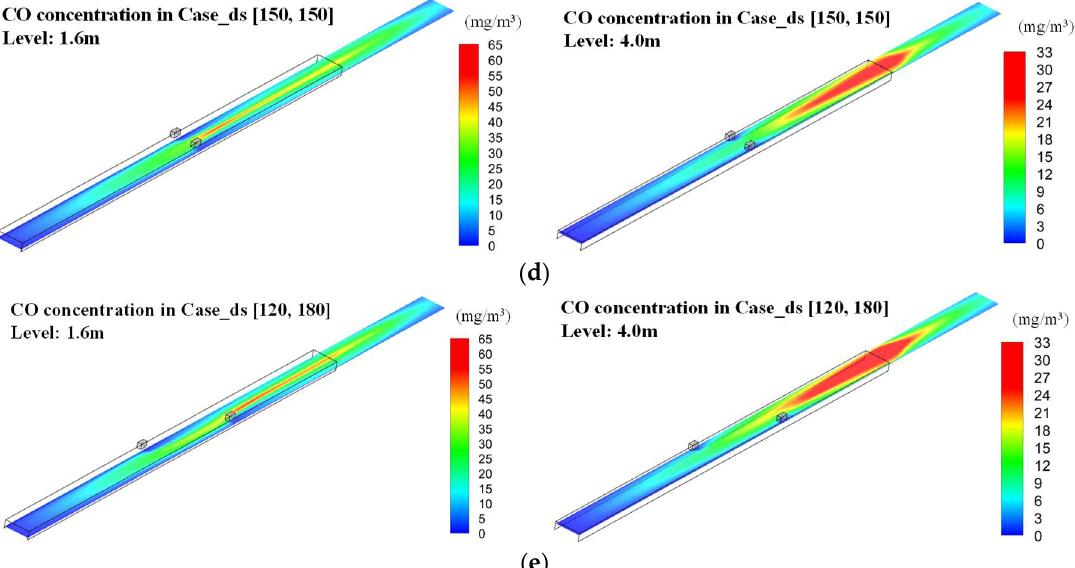
Figure 9. CO concentration on slices at z = 1.6 m and 4.0 m. ( a ) Case [Base]; ( b ) Case_sl [150]; ( c ) Case_ss [150]; ( d ) Case_ds[150, 150]; ( e ) Case_ds [120, 180].